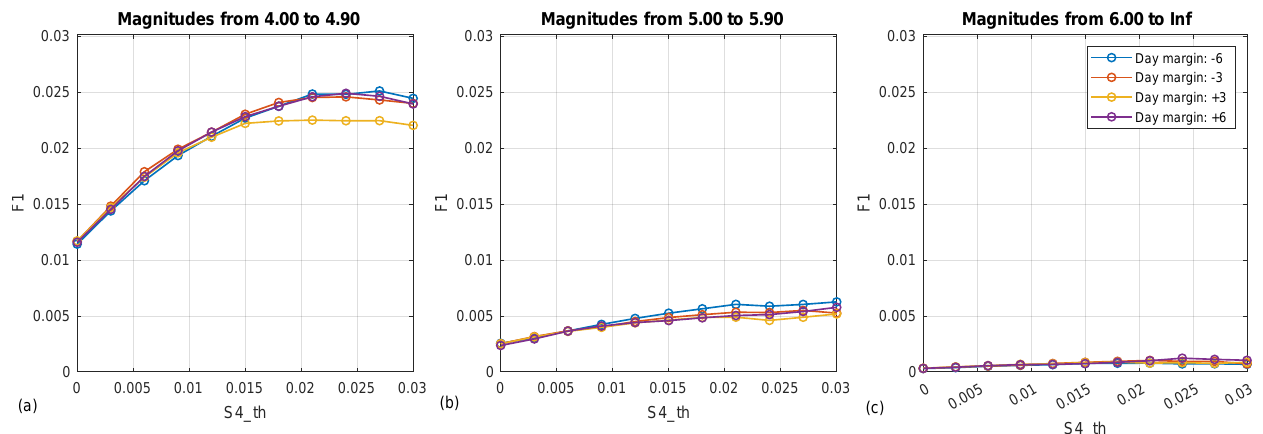
Figure 18. F 1 score values for two magnitude intervals using radius = 100 km with respect to the ∆ S 4 threshold: s 4_ th .